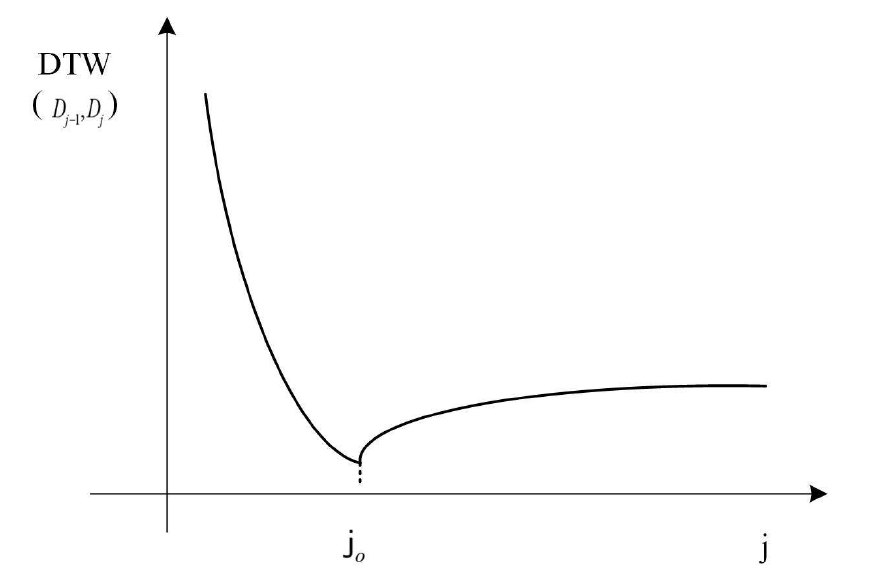
Figure 3. Comparison of HPF and LPF.